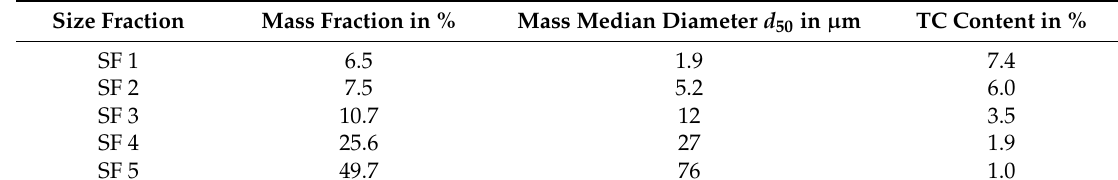
Table 1. Data of the ash size fractions produced.